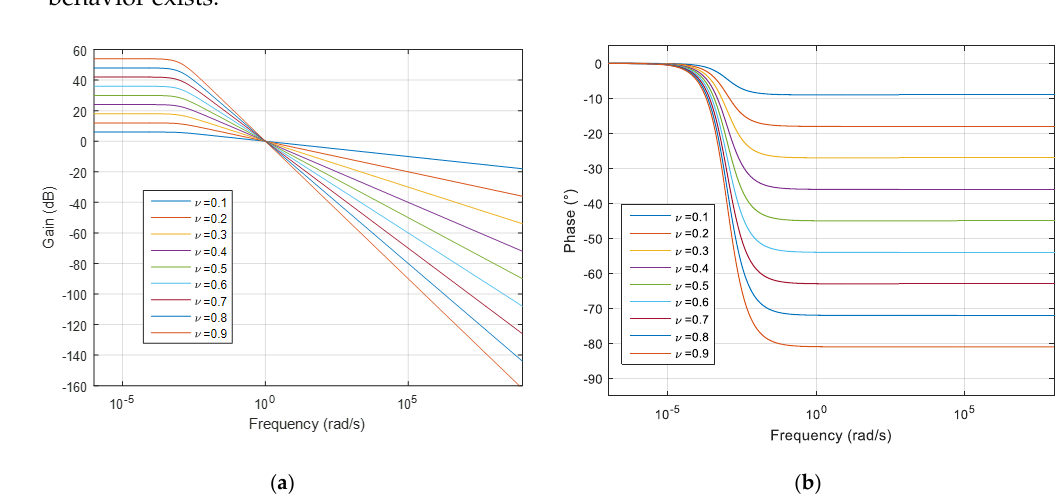
Figure 1. Gain ( a ) and phase ( b ) diagrams of integral I(s) for various values of ν and T f = 10,000.